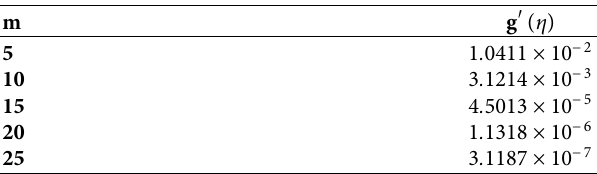
Table 3: The convergence of the flow problem for velocity equation in y direction.